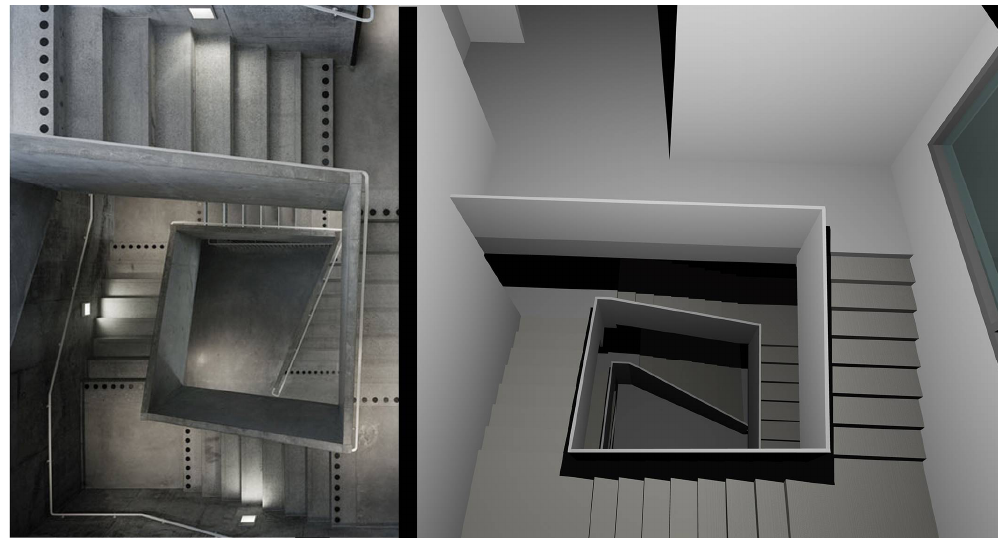
Figure 6. Renderings vs reality. Tham & Videgård Arkitekter, Kalmar Museum of Art—Sweden (Student Sonia